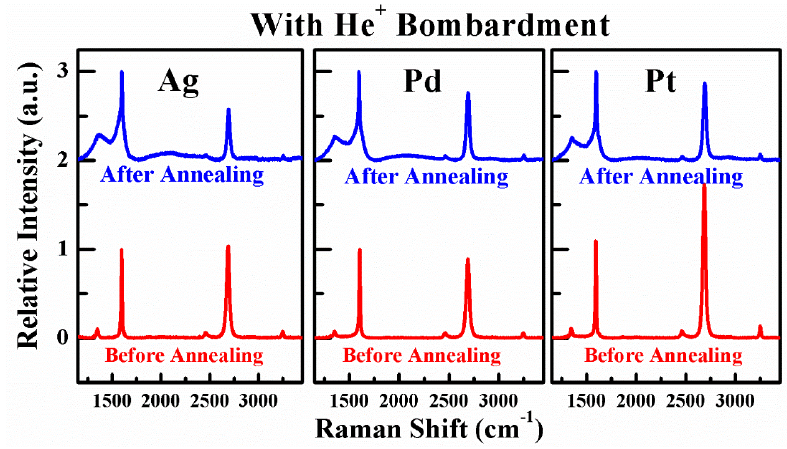
Figure 11. The Raman spectra of the graphene in the G-M contact windows with He + bombardment before and after annealing.